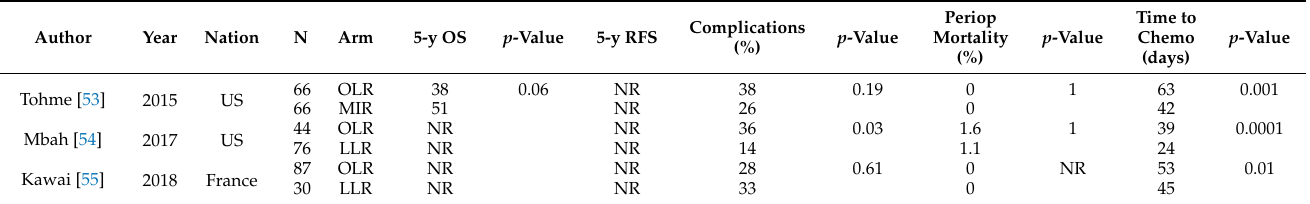
Table 5. Studies evaluating time to adjuvant therapy after liver surgery for colorectal liver